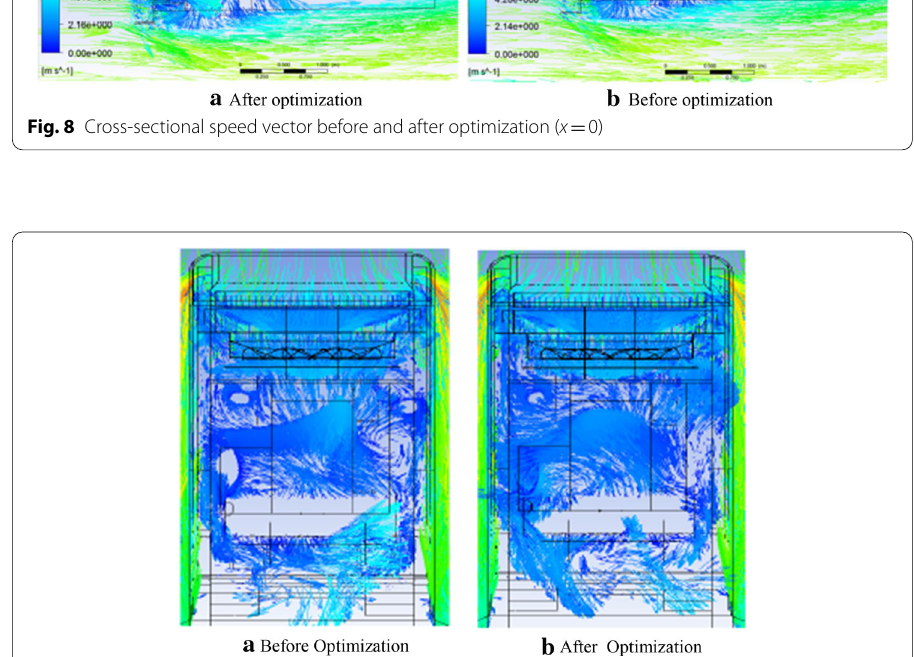
Fig. 9 Cross‑sectional speed vector before and after optimization ( z